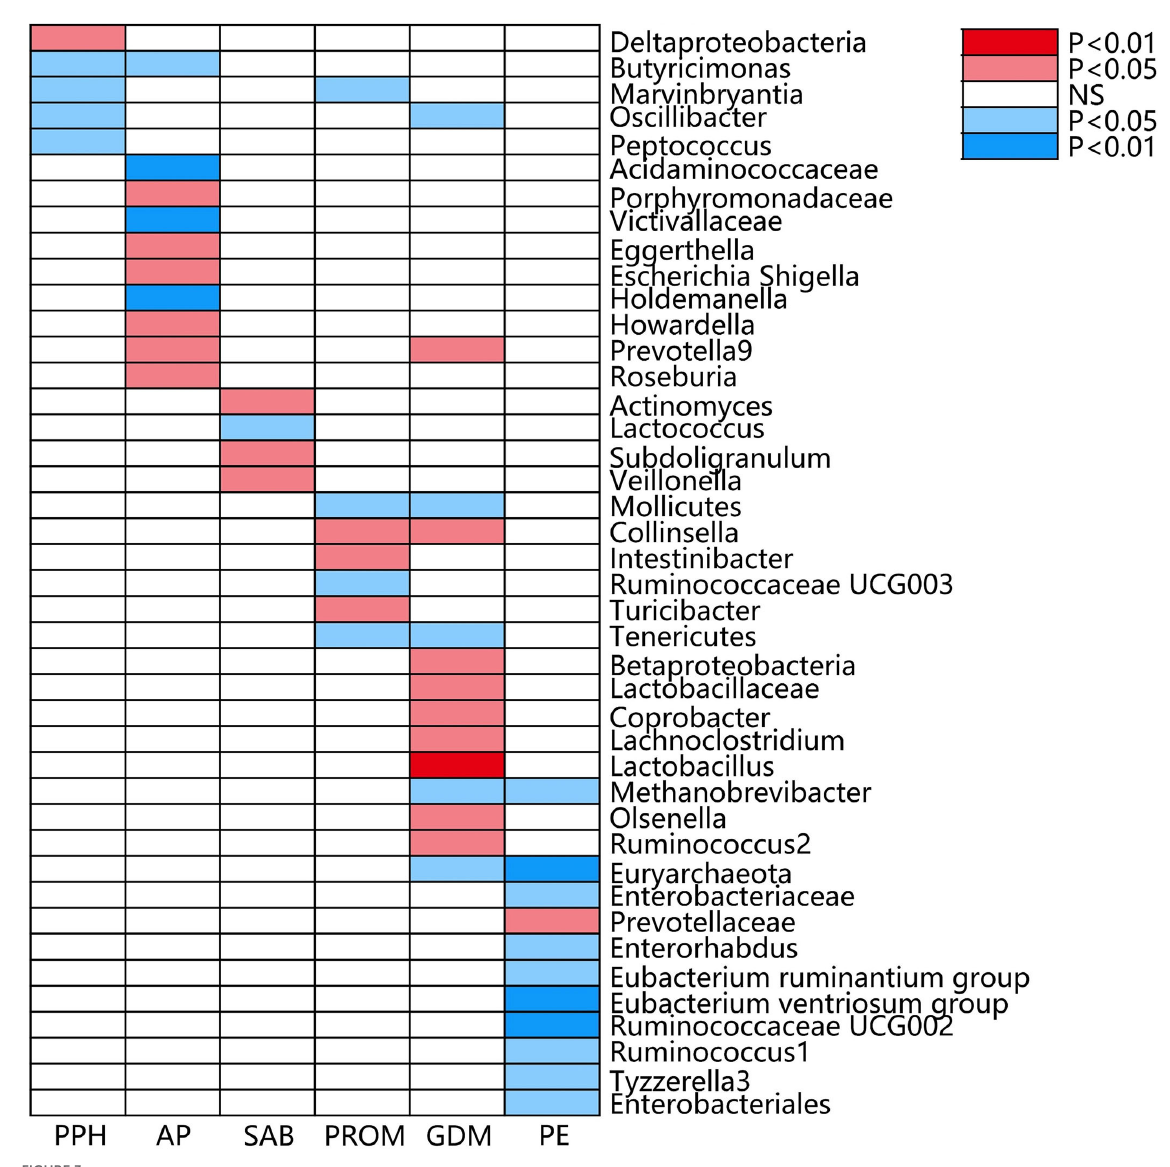
FIGURE3 Causal associations of gut microbial genera on adverse pregnancy outcomes (APOs) identified at the nominal significance from the IVW method ( P < 0.05/0.01). Red represents the risk bacterial traits for APOs, blue represents the protective bacterial traits for APOs, and white represents no causal bacterial traits for APOs. PPH, postpartum hemorrhage; AP, abruptio placentae; SAB, spontaneous abortion; PROM, premature rupture of membrane; GDM, gestational diabetes mellitus; PE, pre-eclampsia; NS, no significant